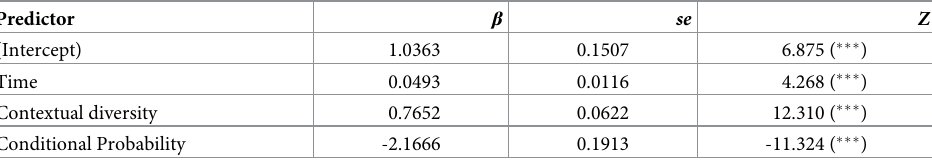
Conditional Probability Outcome of the logistic mixed-effect model fitted considering all significant predictors at once on categorization outcomes obtained using cosine as the distance metric to retrieve nearest neighbors. Significance codes: ( ��� ): p <